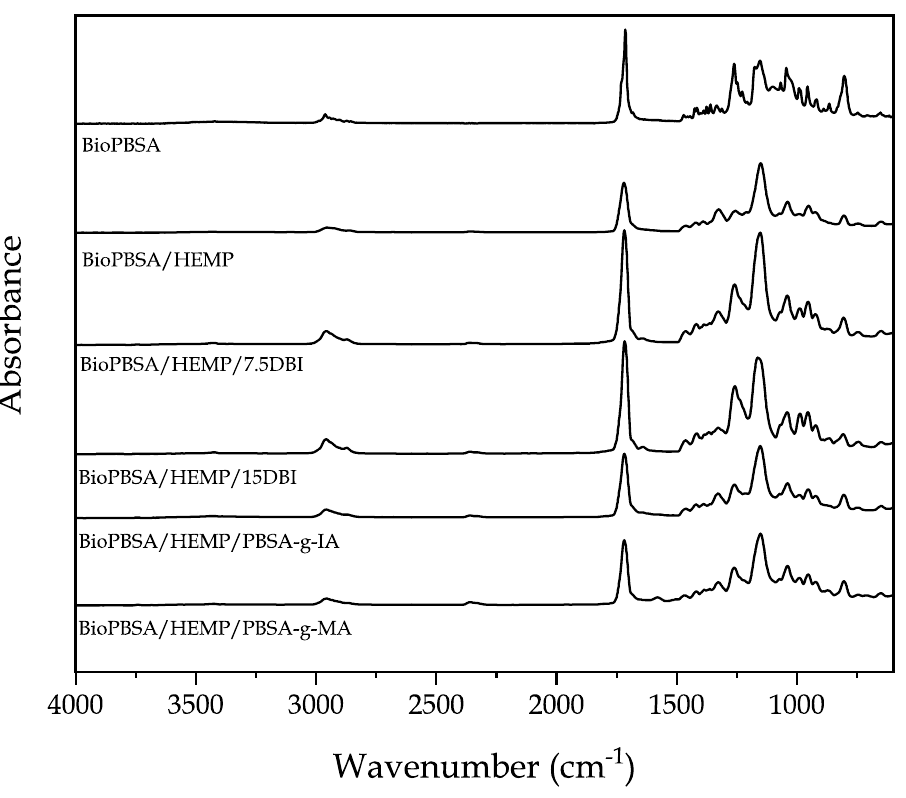
Figure 2. FTIR spectra of the uncompatibilized and compatibilized BioPBSA/HEMP composites.